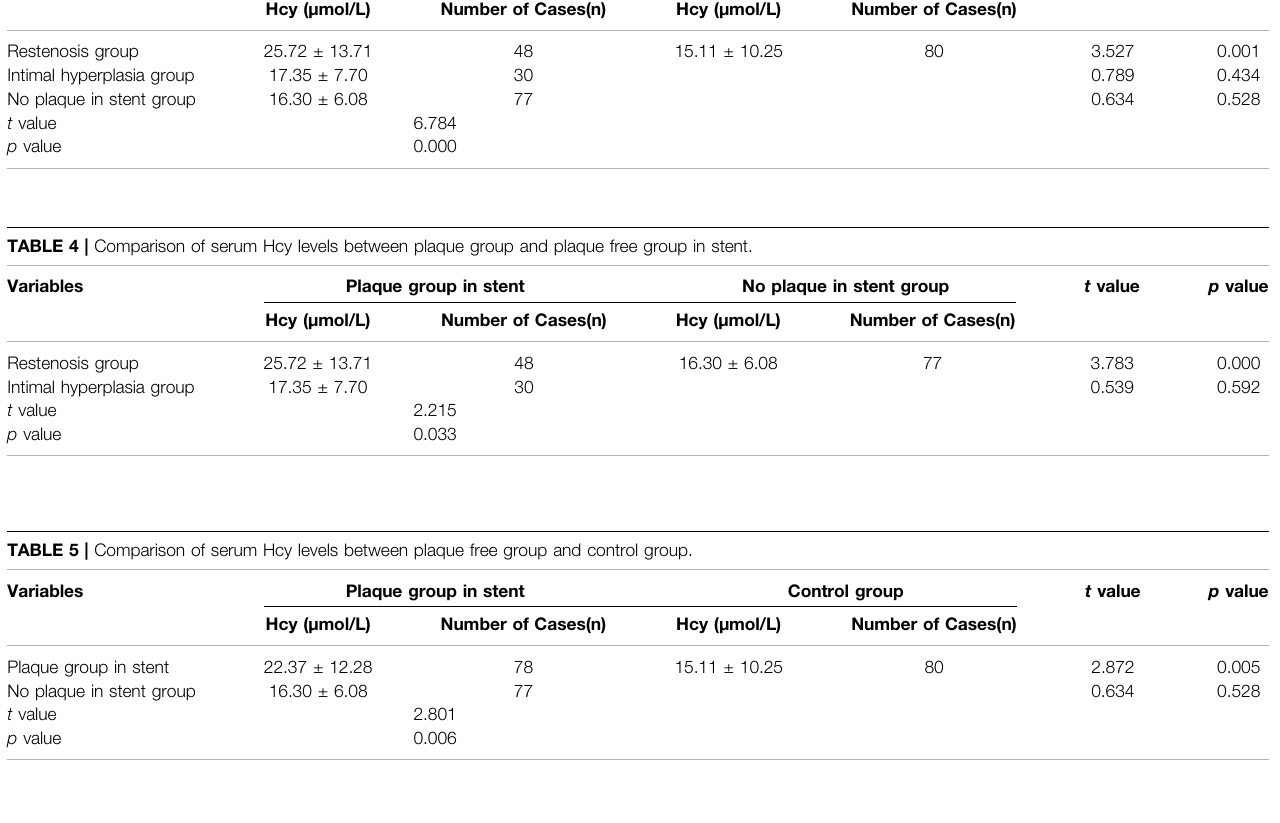
TABLE 3 | Comparison of serum Hcy levels between restenosis group and intimal hyperplasia group. Variables